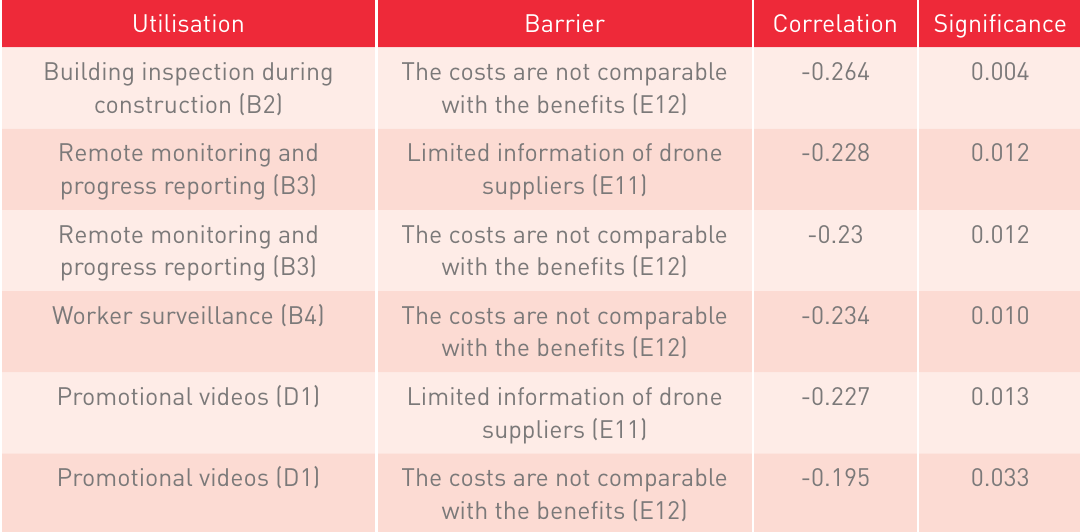
Table 16. Correlations between the level of utilisation and barriers